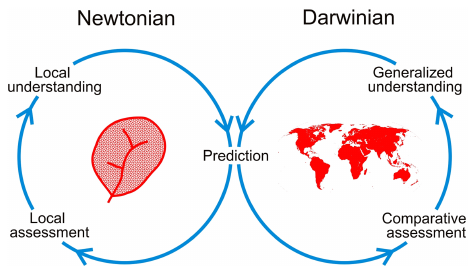
Figure 9. Newtonian–Darwinian synthesis: relative contributions of Newtonian (learning from individual catchments through detailed studies) and Darwinian (learning from a population of catchments through comparative studies) approaches (taken from Blöschl et al.,